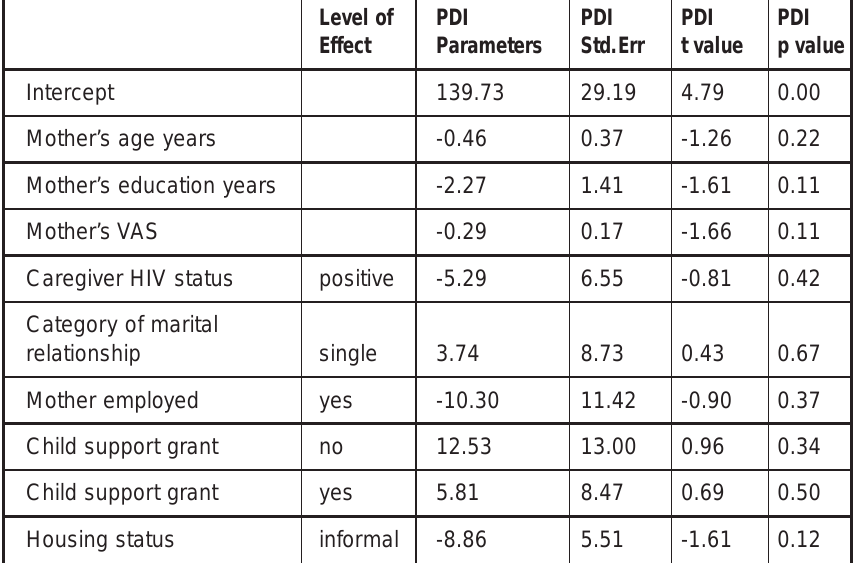
Table 3: Results of the GLM to determine interaction effects of maternal characteristics with the PDI.